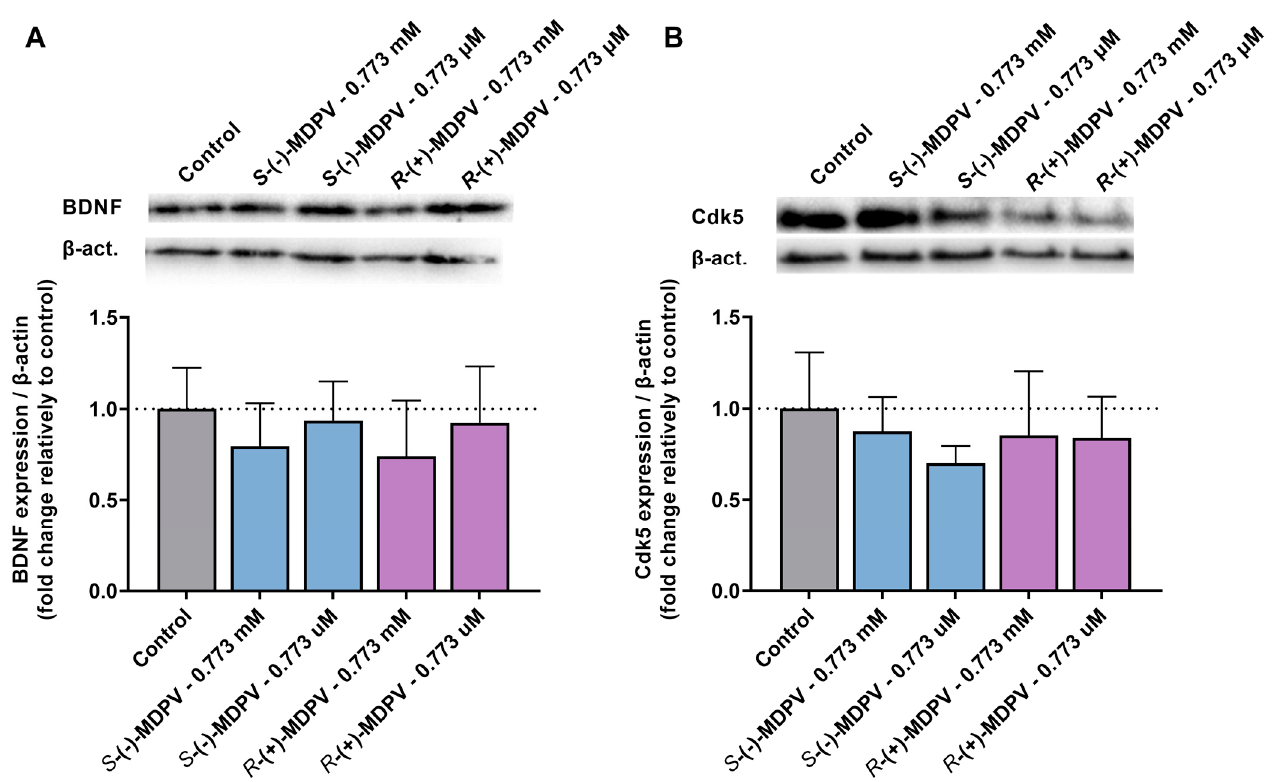
Figure 9. Effects of the enantiomers of MDPV in BDNF ( A ) and Cdk5 ( B ) expression in undifferentiated SH-SY5Y cells. The expression was normalized by β -actin. Results are expressed as mean ± SD for the fold change relative to control samples for at least four independent experiments ( n = 4) performed in duplicate.